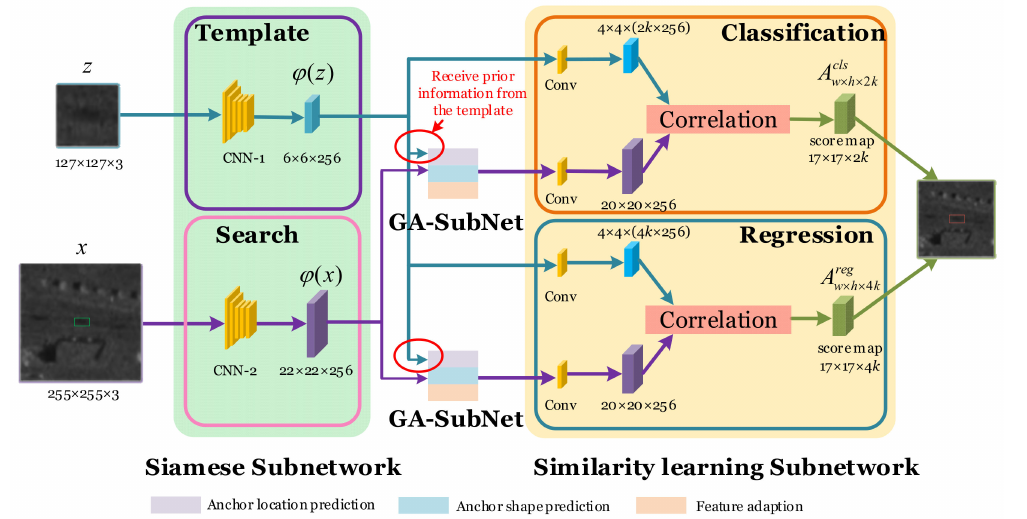
Figure 1. The architecture of